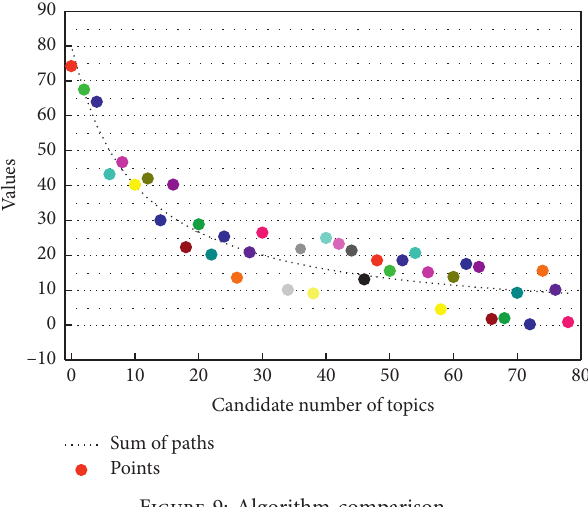
Figure 9: Algorithm